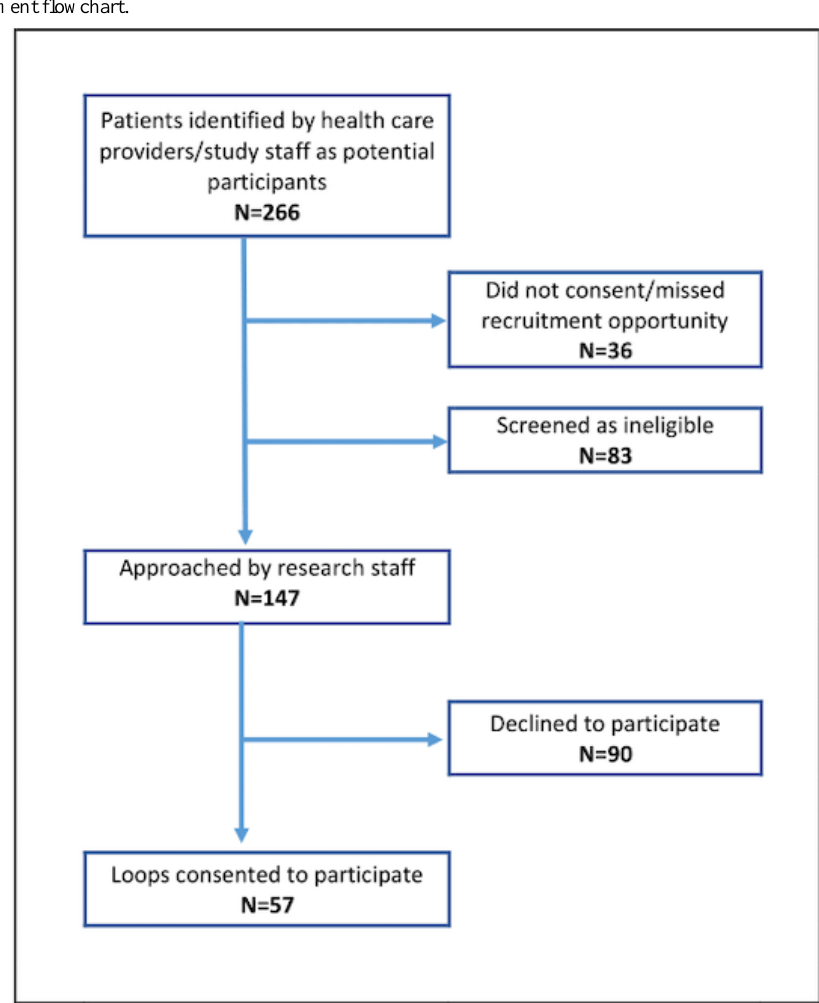
Figure 4. Patient recruitment